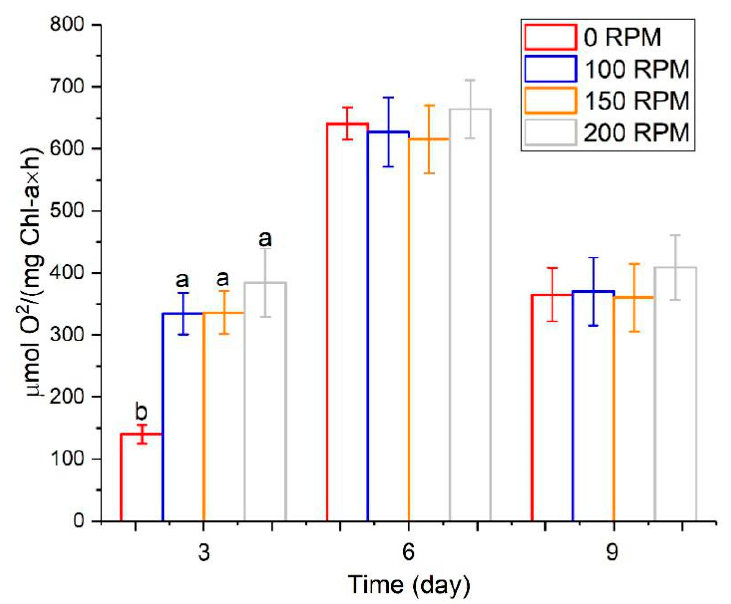
Figure 5. The rate of photosynthetic oxygen evolution of Microcystis aeruginosa under different turbulence conditions. Error bars represent the SD of triplicate samples. Different letters indicate significance between different treatments ( p < 0.05).